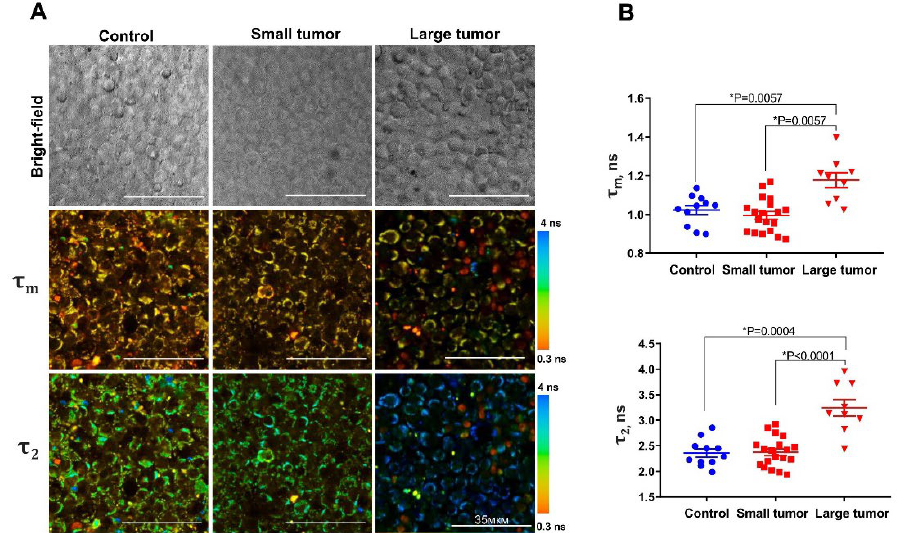
Figure 2. FLIM of NAD(P)H in LNs of intact and tumor-bearing mice. ( A ) Representative FLIM images of the mean fluorescence lifetime τ m and long lifetime component τ 2 . ( B ) Quantification of fluorescence lifetime parameters. Scatter dot plot displays the measurements for individual animals (dots) and the mean and SEM (horizontal lines).